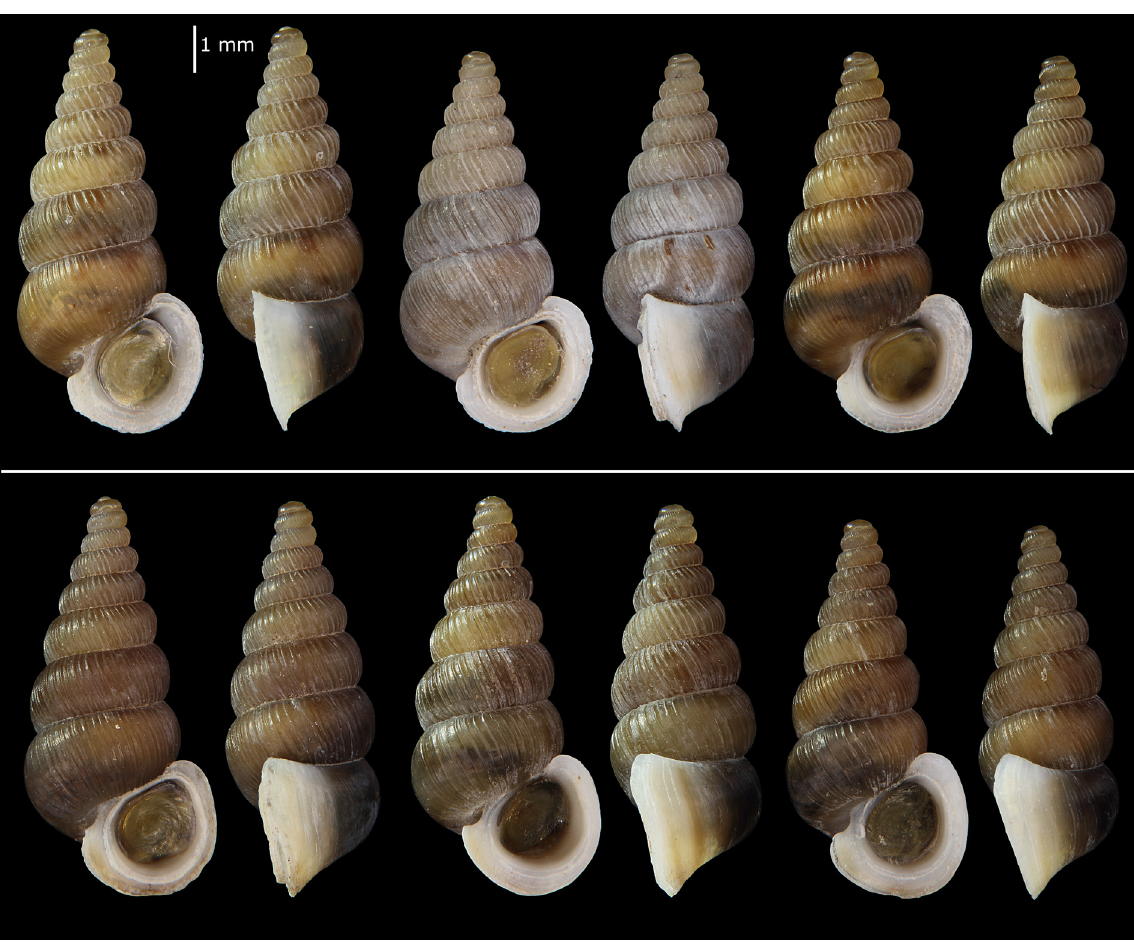
Fig. 36. Top: Cochlostoma ( Clessiniella ) tergestinum (Westerlund, 1878), Mt Snežnik 1161 m a.s.l., Slovenia (WdM7012). Bottom: Co. ( Cl. ) waldemari (A.J. Wagner, 1897), Mt Snežnik 1150 m a.s.l., Slovenia